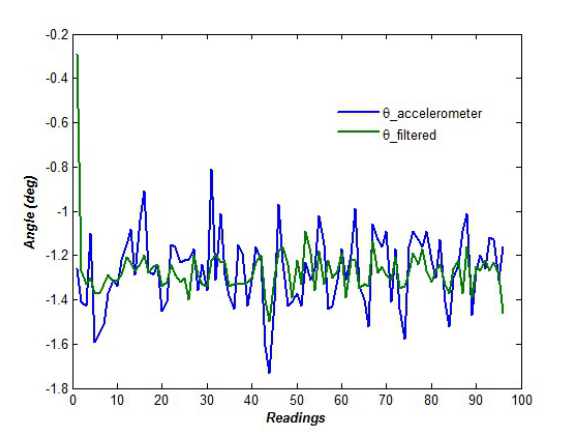
Figure 6: Filtered vs. accelerometer data in a static position.